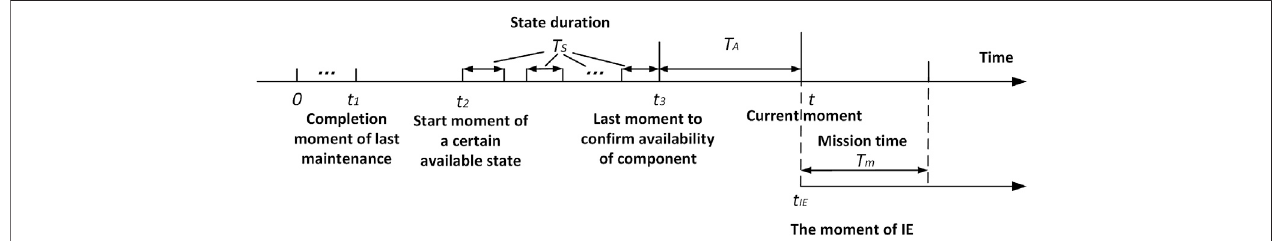
FIGURE A1 | Schematic diagram of time-dependent